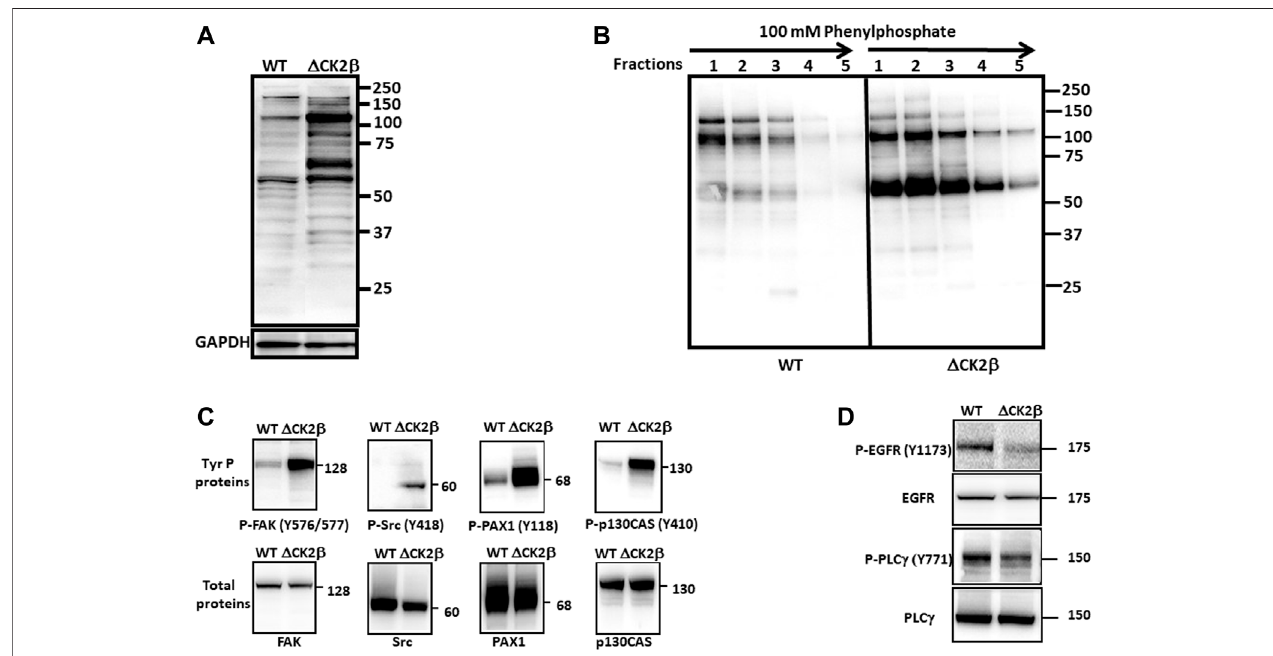
FIGURE 3 | Upregulation of pTyr proteins in lysates of Δ CK2 β MCF10A cells. (A) Lysate s from WT and Δ CK2 β MCF10A cells were analyzed for pTyr-containing proteins using the 4G10 antibody. GAPDH was used as a loading control. (B) Cell extracts (500 μ g of protein) of WT and Δ CK2 β MCF10A cells were loaded on 4G10 resin.Afterextensivewashing,theboundproteinswereelutedwith100 mMphenylphosphate.ThecollectedfractionswereanalyzedbyWesternblottingwiththe4G10 antibody. (C) Proteins immunopuri fi ed from WT and Δ CK2 β MCF10A cell lysates were analyzed by Western blotting for p-FAK (Y576/577), p-Src (Y418), p-PAX1(Y118), p-p130CAS (Y410), FAK, Src, PAX1, and p130CAS and (D) for p-EGFR (Y1173), EGFR, p-PLC γ (Y771), and PLC γ